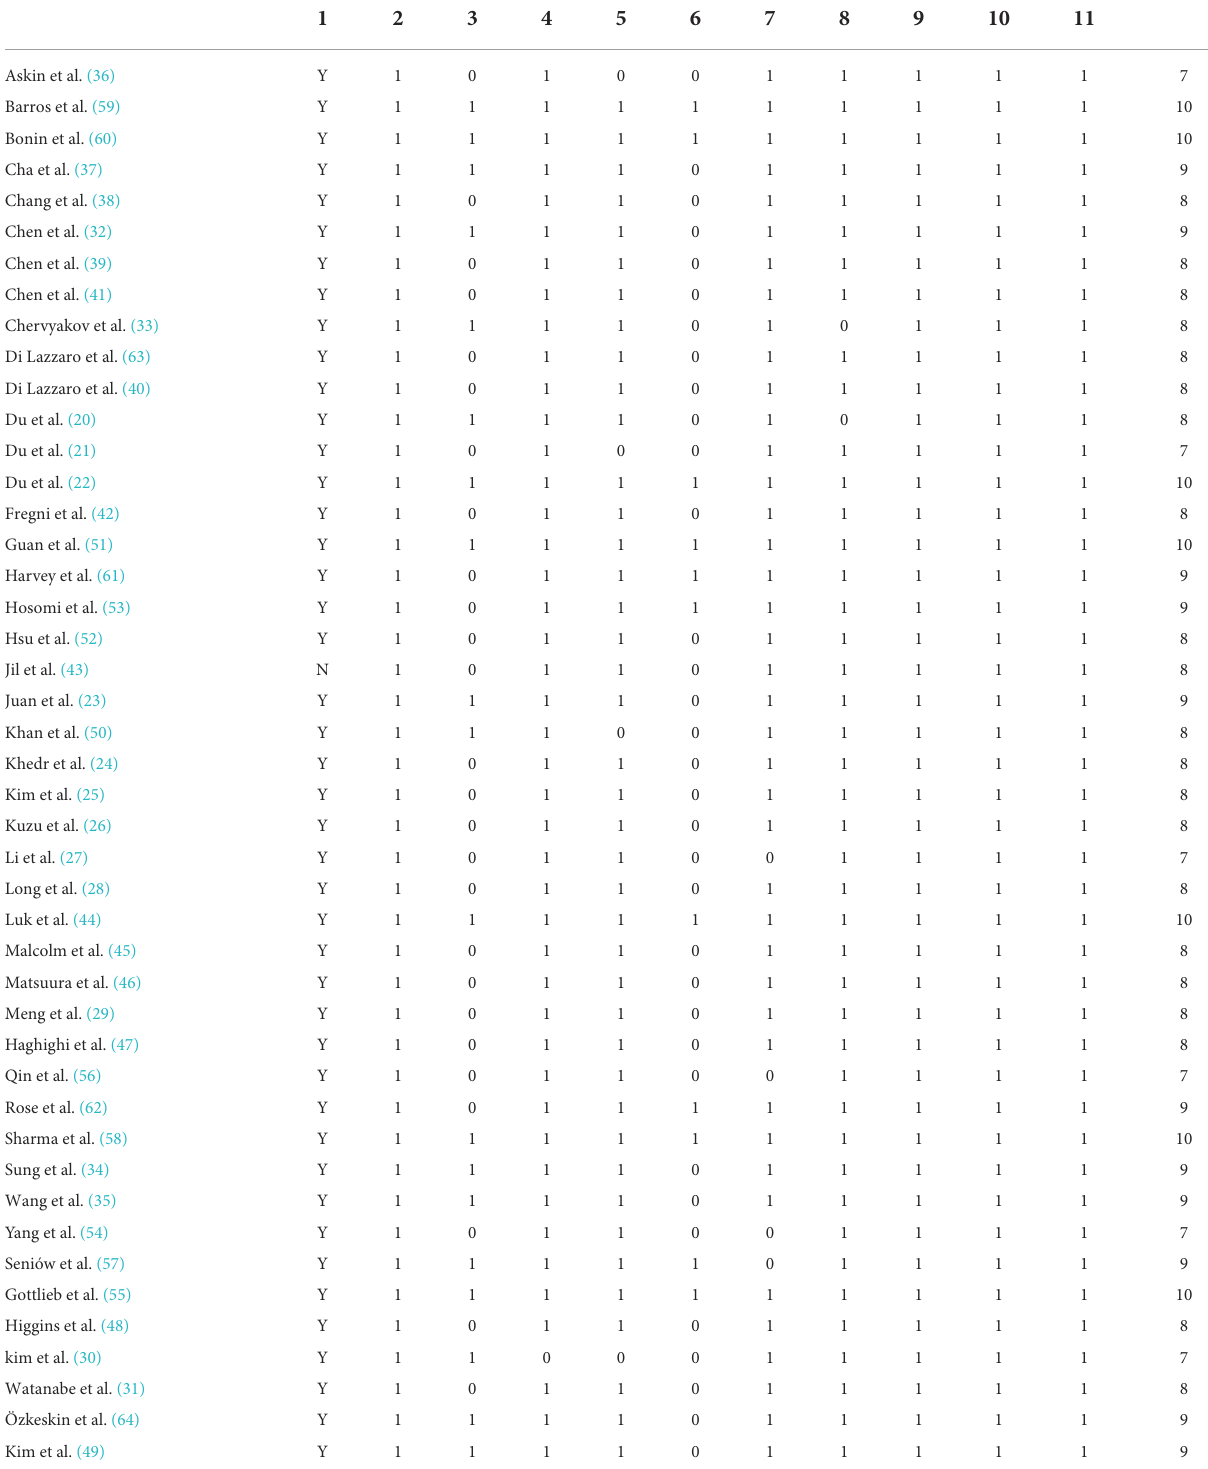
TABLE 1 Assessment of risk of bias in the included